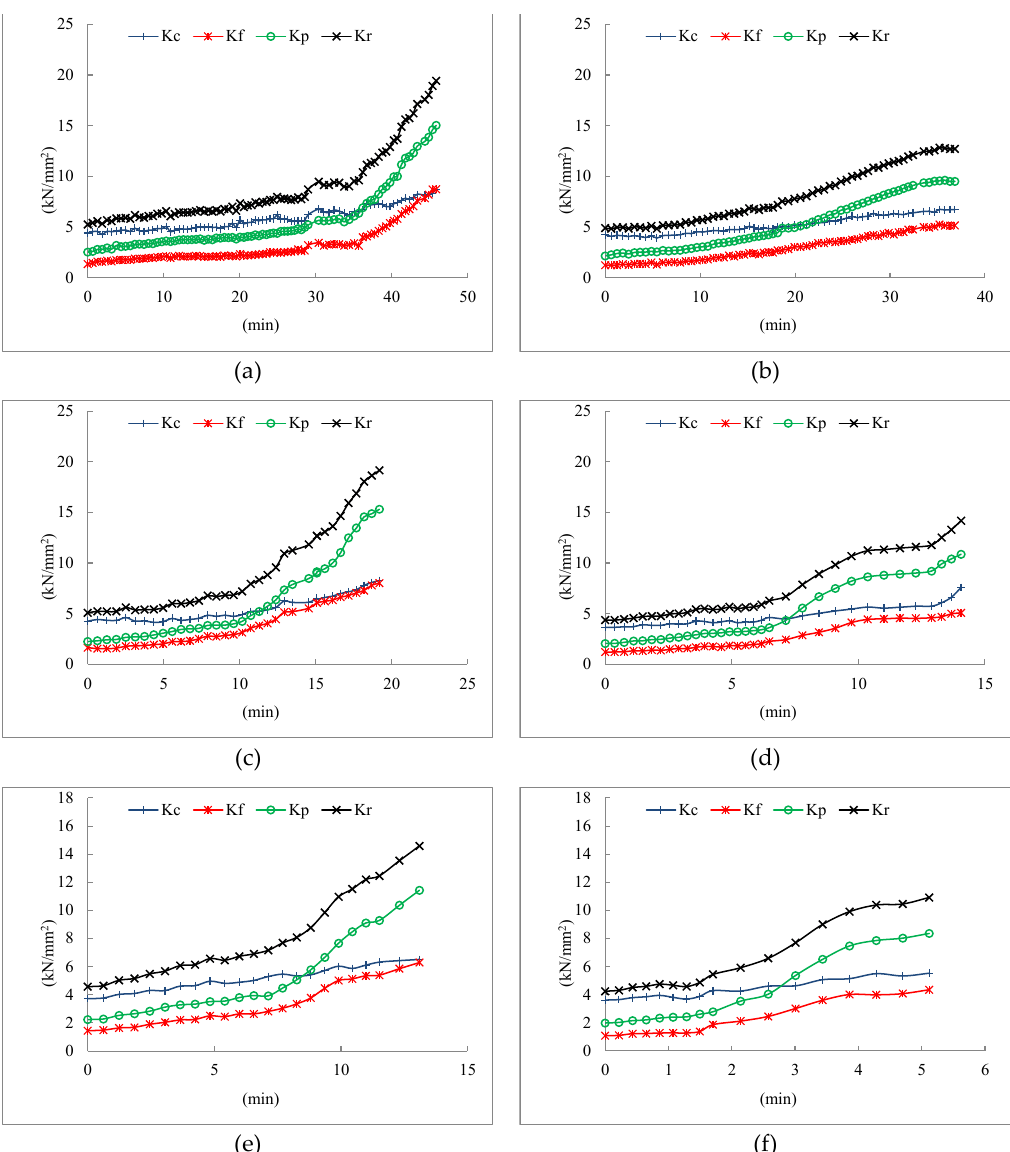
Figure 5. Cutting forces progression for Haynes 282 turning tests with high pressure cooling. ( a ) Vc = 50 m/min and f = 0.1 mm/rev; ( b ) Vc = 50 m/min and f = 0.15 mm/rev; ( c ) Vc = 70 m/min and f = 0.1 mm/rev; ( d ) Vc = 70 m/min and f = 0.15 mm/rev; ( e ) Vc = 90 m/min and f = 0.1 mm/rev; ( f ) Vc = 90 m/min and f = 0.15 mm/rev